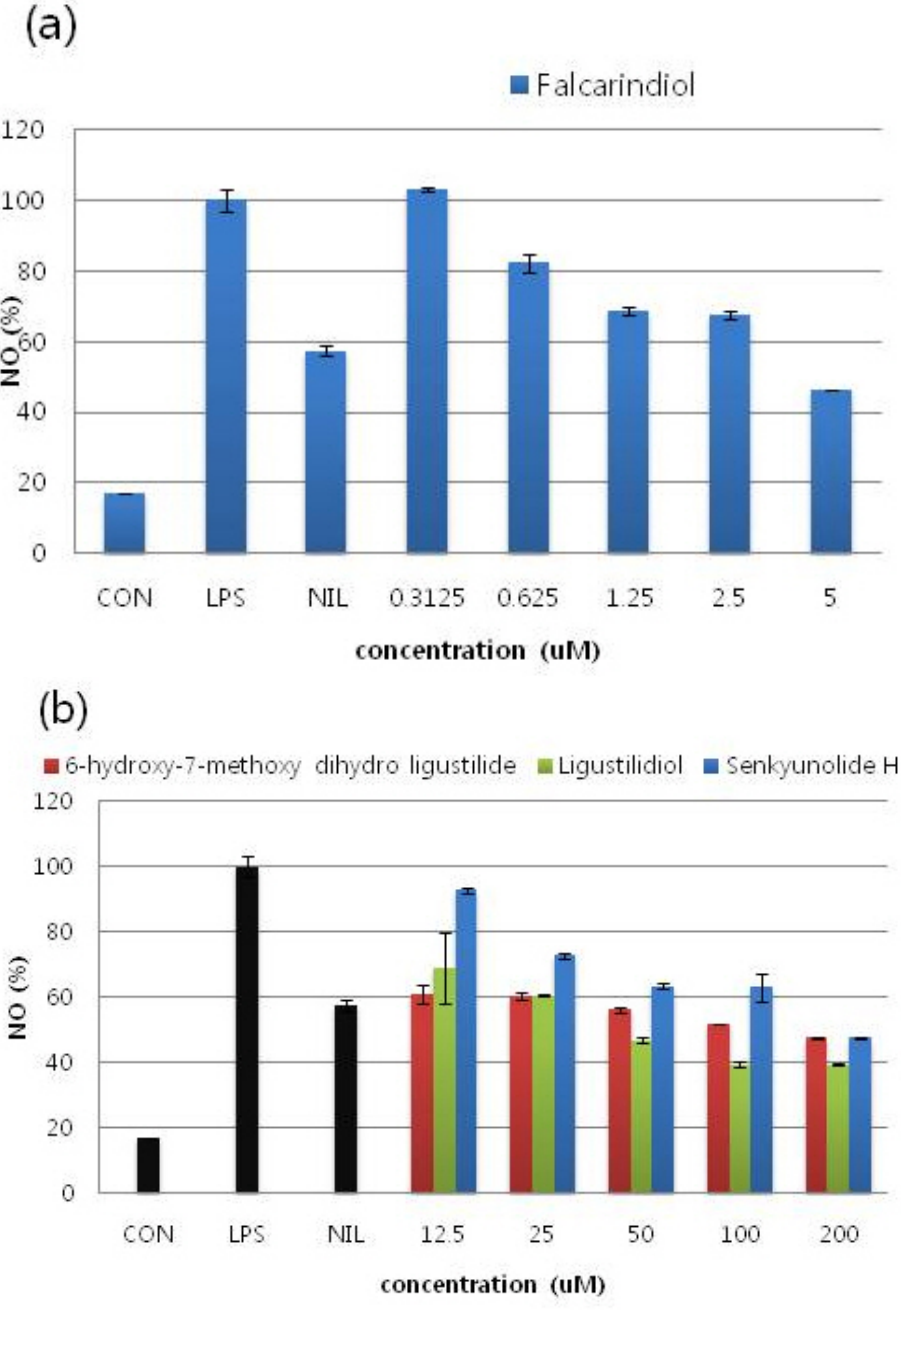
Figure 3. The effects of each compound with various concentrations on NO production. It was determined by measuring the level of nitrite accumulation in culture media. Among these compounds, falcarindiol showed the highest inhibition percentage for the release of NO from RAW 264.7 macrophage cells. Measuring nitric oxide accumulation each experiment was performed in triplicates and repeated at least three times. ( a ) Falcarindiol; ( b ) ( Z )-6-hydroxy-7-methoxy-dihydroligustilide, Ligusilidiol, Senkyunolide